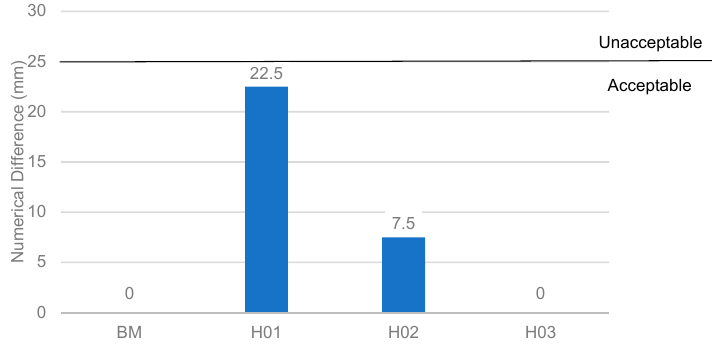
Figure 16. Numerical difference of the J-Ring flow and slump flow for hybrid SCC samples.